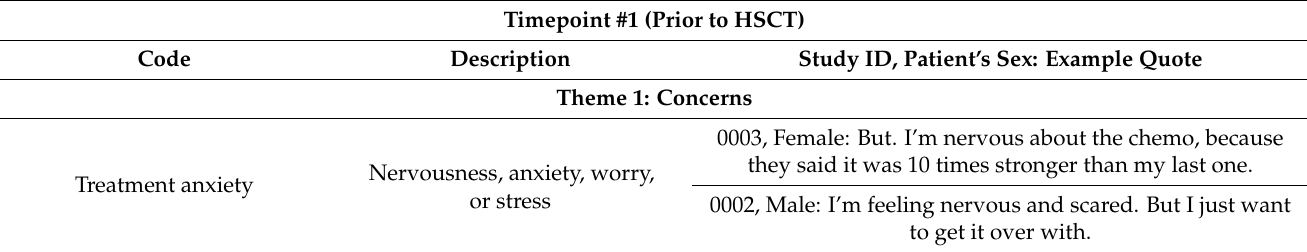
Table 2. Themes and codes from semi-structured interviews of AYA HSCT